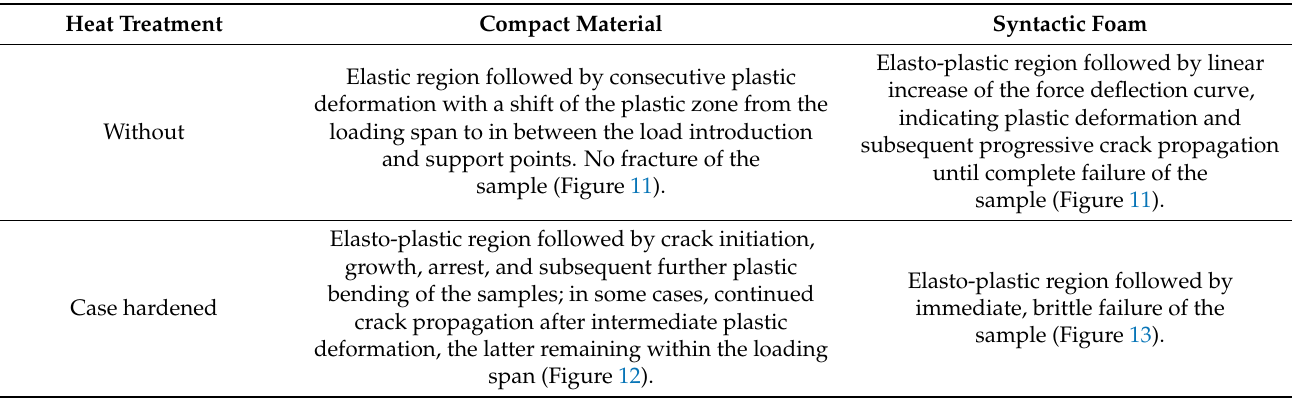
Table 7. Failure mechanisms under a 4-point bending load of reference samples without microspheres (compact material), and syntactic foam samples with and without case hardening treatment, as expressed in the force-deflection curves. Heat